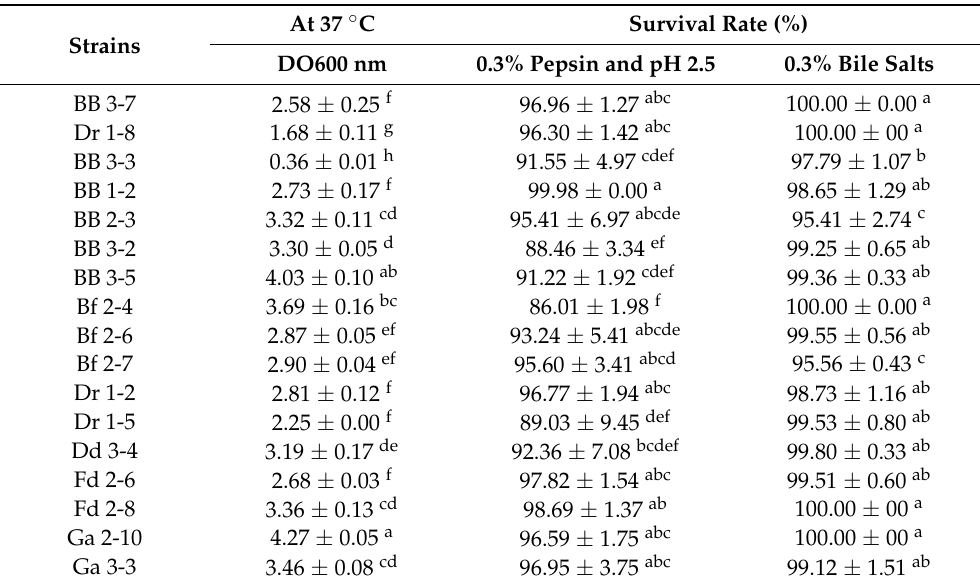
Table 2. Assessment of the capacities of yeast strains to grow at 37 ◦ C and resist the simulated gastrointestinal conditions. At 37 ◦ C Survival Rate (%) Strains DO600 nm 0.3% Pepsin and pH